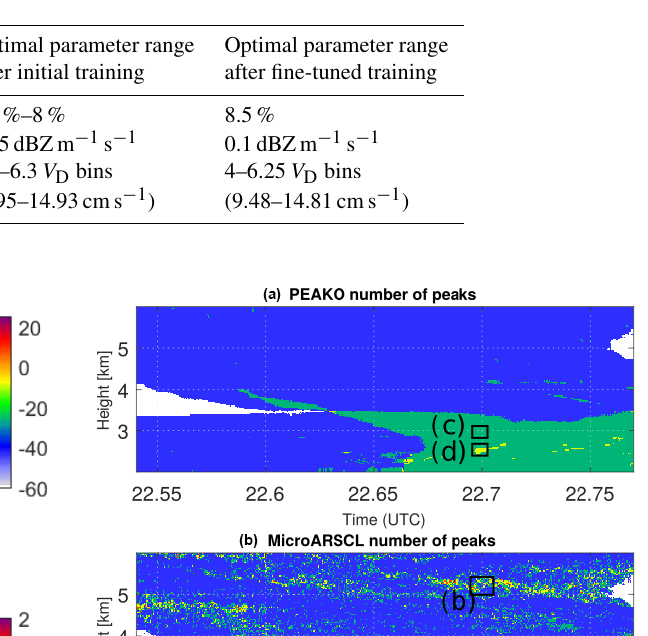
Table 2. Ranges of the parameters yielding the highest similarity measure after the initial and the finely tuned training using the first and second training data sets, respectively.